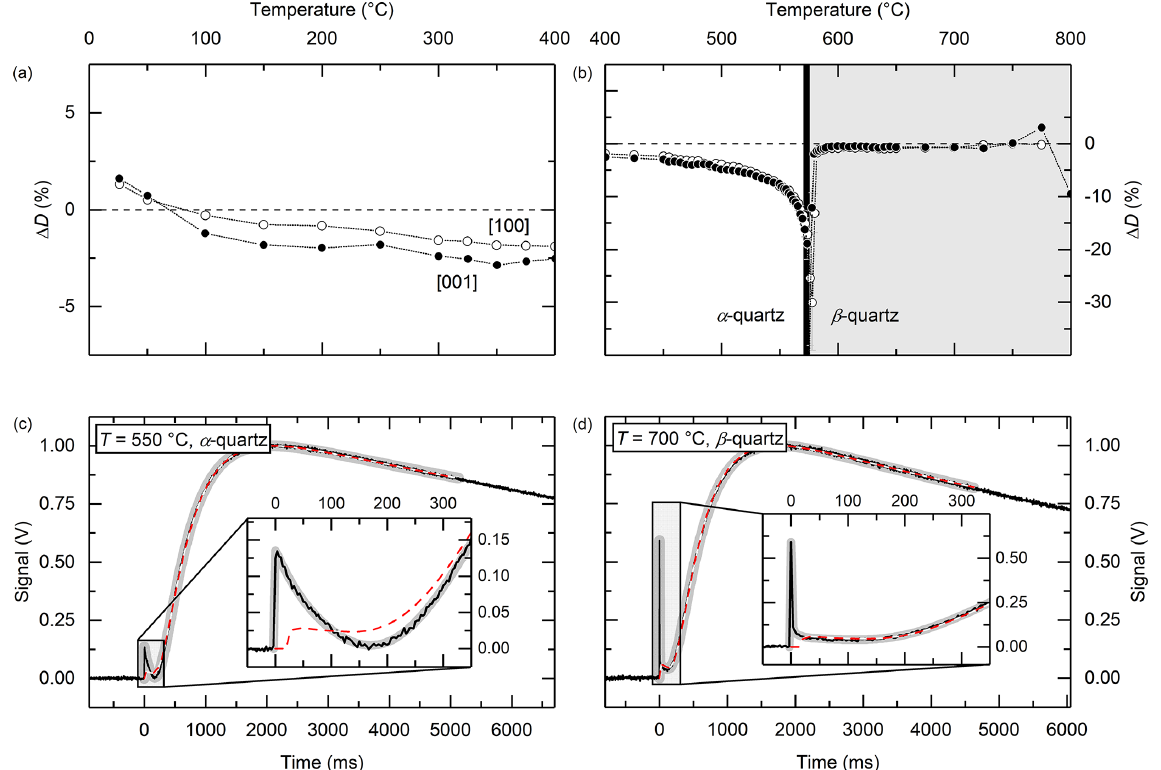
Figure 7. Comparison of the fit results using different model approaches to approximate HT1 data below and above the α – β phase transition. Panels (a) and (b) illustrate the differences (cid:49)D between thermal diffusivities evaluated by the approximation approach proposed in this study (i.e. accounting for direct radiative heat transfer differently for T ≤ 573 ◦ C and T > 573 ◦ C) and the model for (semi)transparent specimens by Mehling et al. (1998) (as implemented in the manufacturer’s software). Exemplary data fits to measurements along the c -axis direction at T = 550 ◦ C and T = 700 ◦ C are shown in panels (c) and (d) , respectively. The measured IR detector signal–time curves are given as black lines. Data fits to 8 × t 1 / 2 are given as thick grey (this study) and dashed red lines (after Mehling et al., 1998). The front part of the fast radiative heat transfer is shown enlarged in the insets. Corresponding thermal diffusivities are (c) D = 0 . 89 ( 3 ) mm 2 s − 1 (this study), D = 0 . 82 ( 5 ) mm 2 s − 1 (Mehling et al., 1998), (d) D = 0 . 98 ( 3 ) mm 2 s − 1 (this study) and D = 0 . 97 ( 4 ) mm 2 s − 1 (Mehling et al.,